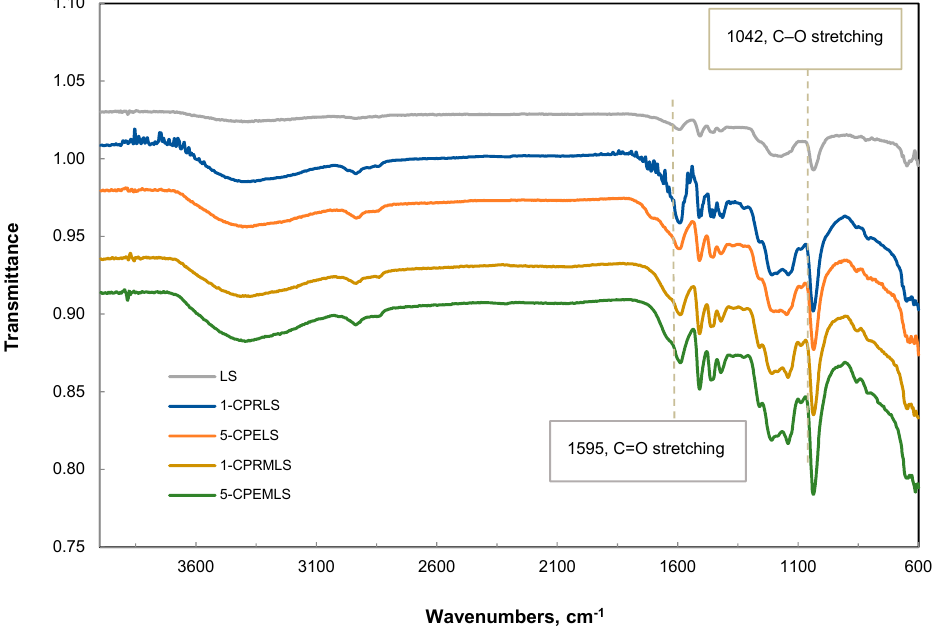
Figure 4. FT-IR spectra for LS, 1-CPRLS, 5-CPELS, 1-CPRMLS, and 5-CPEMLS.